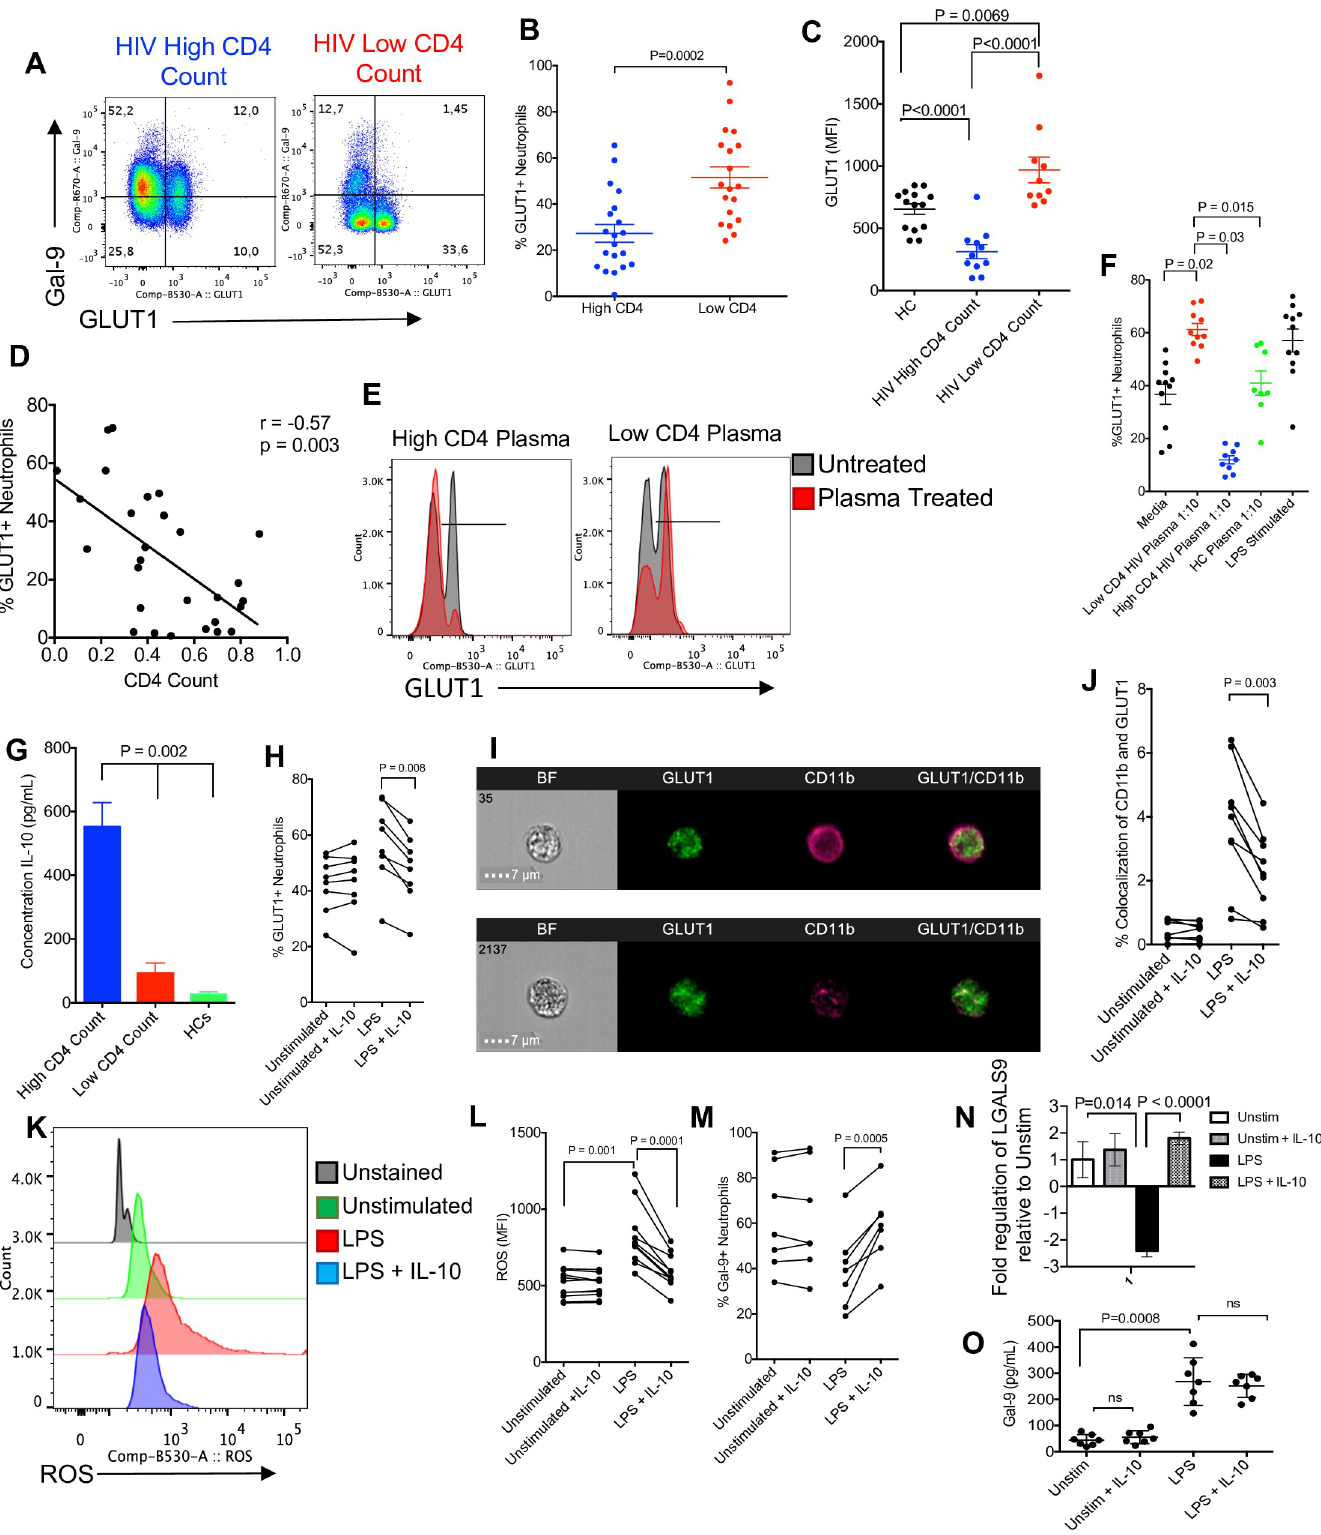
Fig 8. Neutrophils from HIV-infected individuals with high CD4 T-cell count have increased IL-10 activity and decreased glycolysis. (A) Representative plots and (B) cumulative data of GLUT1 and Gal-9 expression in neutrophils of HCs versus HIV patients with low or high CD4 T-cell count. (C) Cumulative data showing the